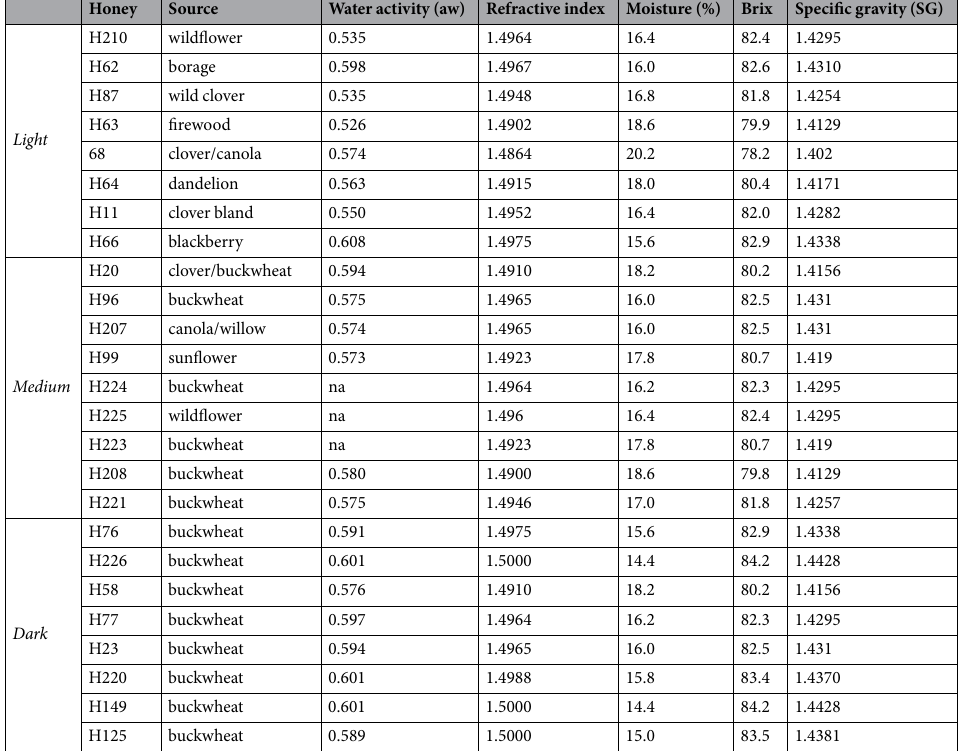
Table 1. Water activity, refractive index, percentage of moisture and sugars and specific gravity of tested